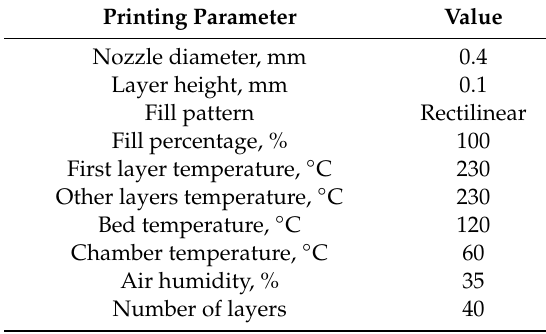
Table 3. Parameters of 3D printing of investigated